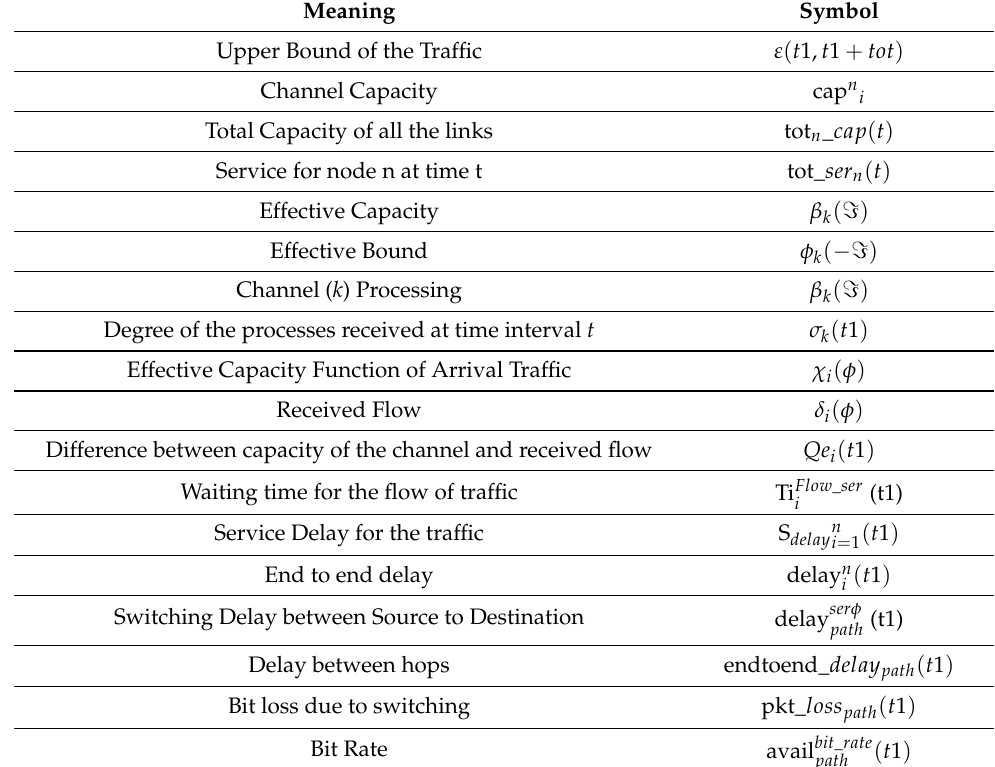
Table 2. Meaning of symbols used in equations for delay in traffic